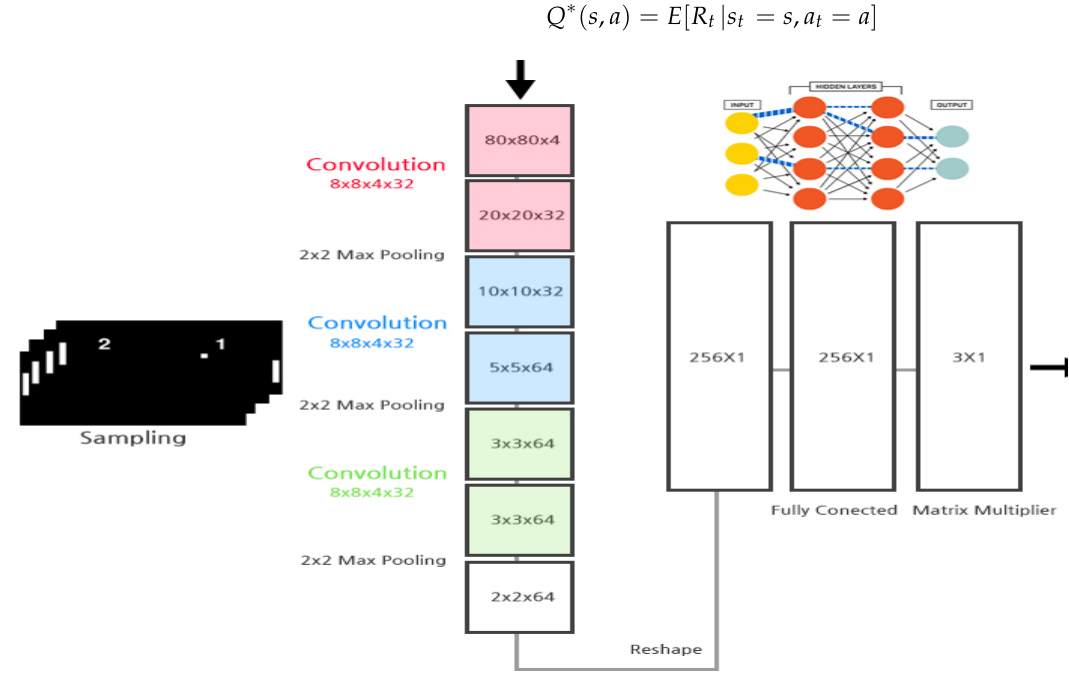
Figure 15. The structure of the implemented artificial neural network.